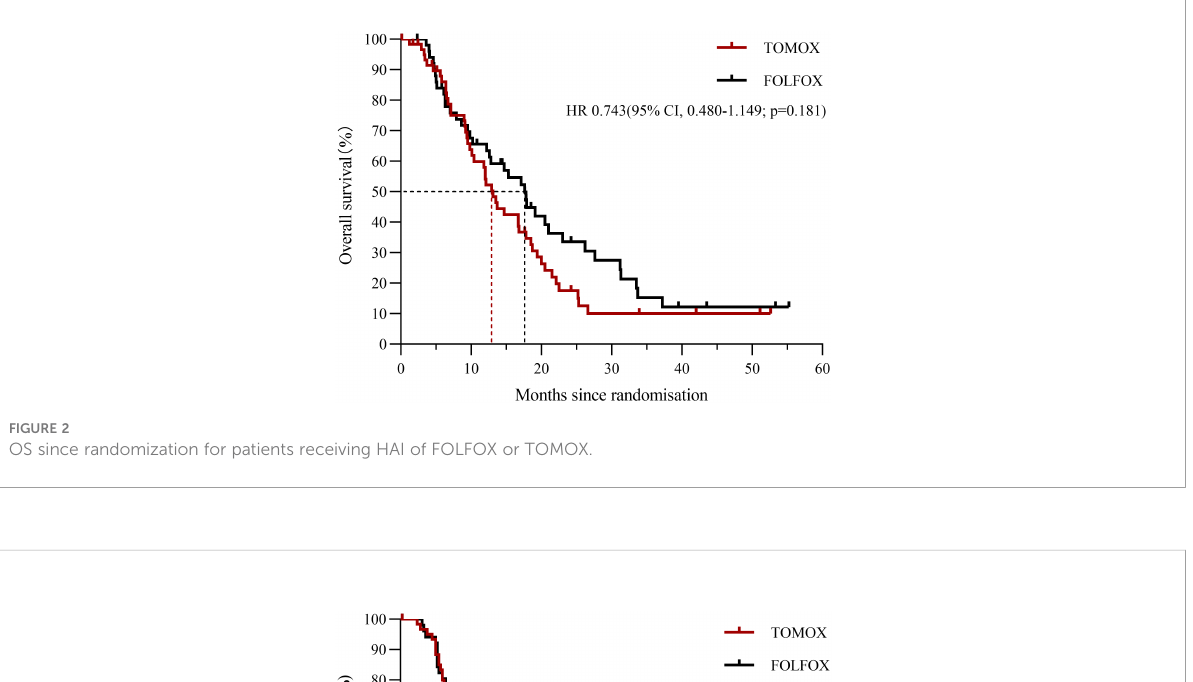
arm, the median OS was 17.8 months in the FOLFOX arm and 12.9 months in the TOMOX arm. For colorectal tumours that